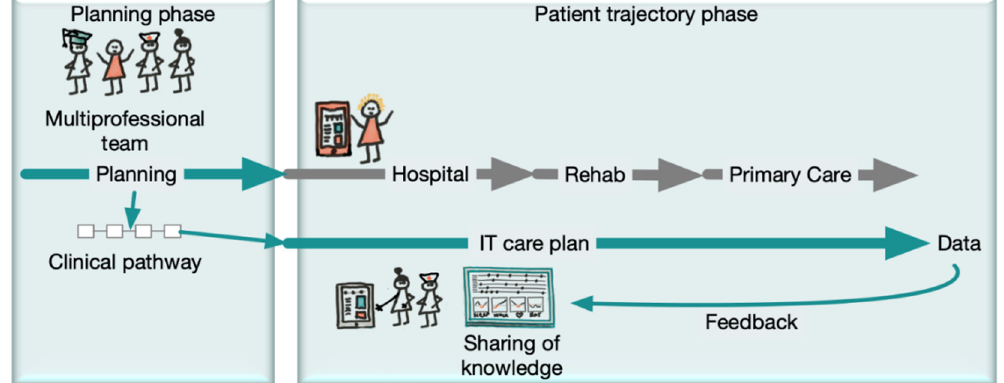
Figure 3. A schematic drawing that demonstrates the organization of the desired IT support system. The multi-professional team designs an optimal clinical pathway and key clinical indicators of disease severity and activity. The clinical pathway is translated to a care plan that provides continuity in the knowledge building along the care trajectory irrespective of provider. The clinical structured data are available in real-time and provide feedback to both healthcare and patients in real-time. Hence, the multi-professional group is supplied with tool for process optimization, patient service, and knowledge sharing.